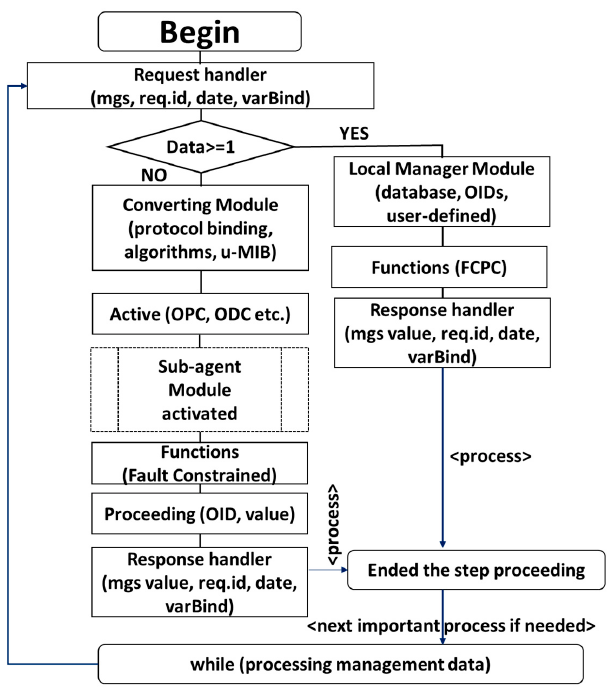
Figure 8. Never-stop mechanism [91] .